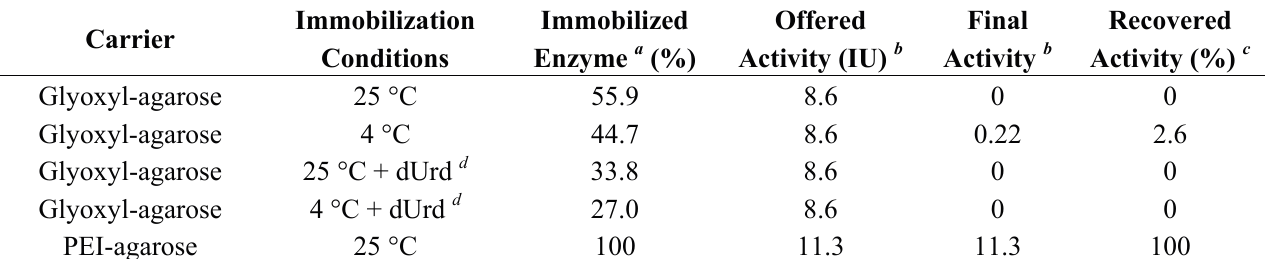
Table 2. Immobilization of Bp NDT on glyoxyl (covalent) and PEI (ionic adsorption) activated